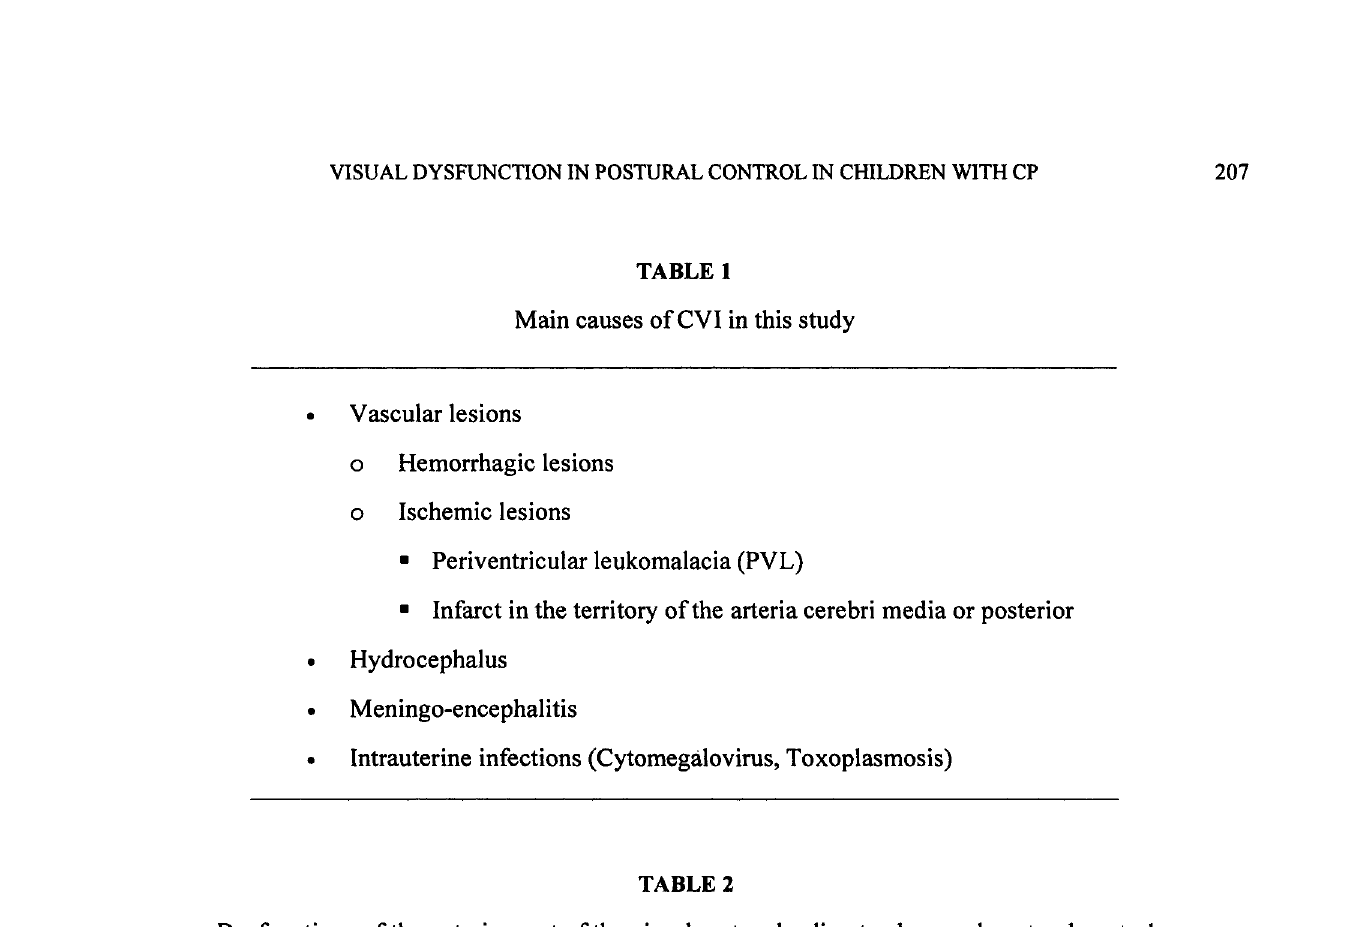
Dysfunctions ofthe anterior part ofthe visual system leading to abnormal postural control a) Ocular